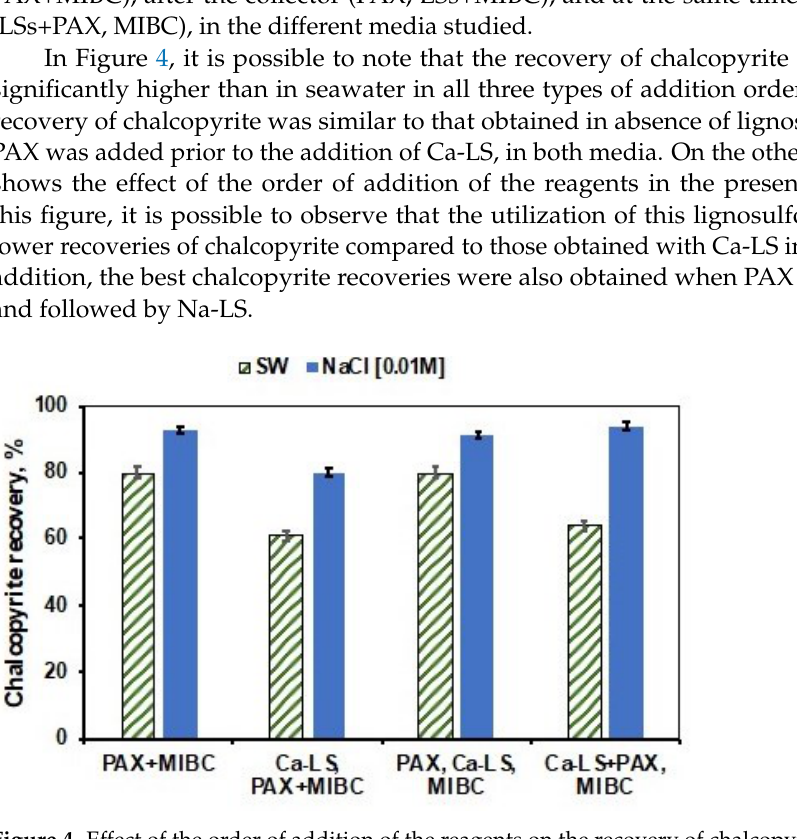
Figure 4. Effect of the order of addition of the reagents on the recovery of chalcopyrite at a concentra- tion of 10 ppm Ca-LS, 25 ppm PAX and 15 ppm MIBC at pH 8 in seawater (SW) and 0.01 M